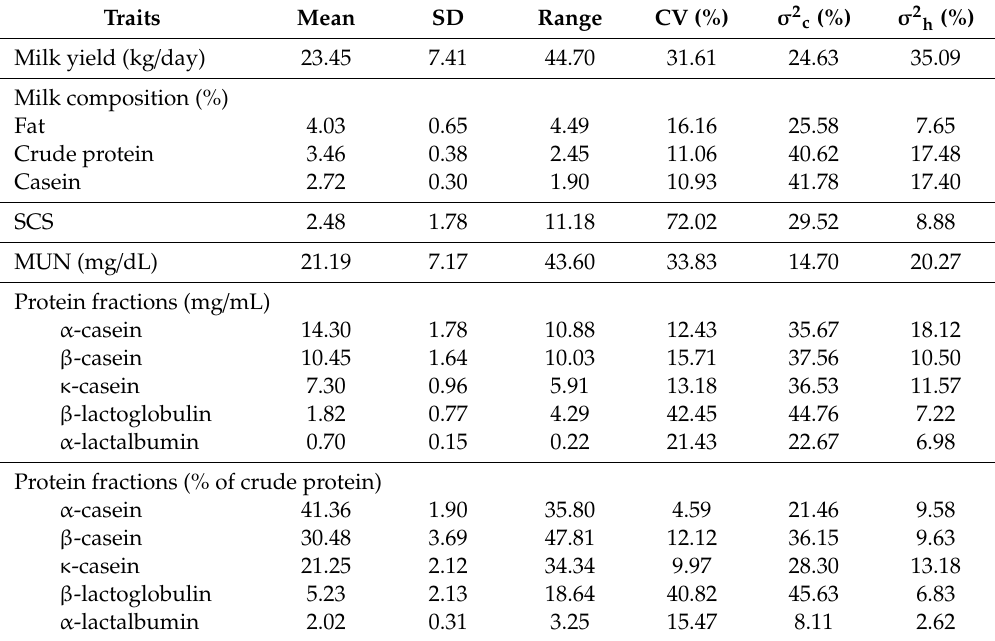
Table 1. Mean, standard deviation (SD), range, coe ffi cient of variation (CV) and percentage of phenotypic variance accounted by cow ( σ 2 c ) and herd ( σ 2 h ) for milk yield, milk composition,